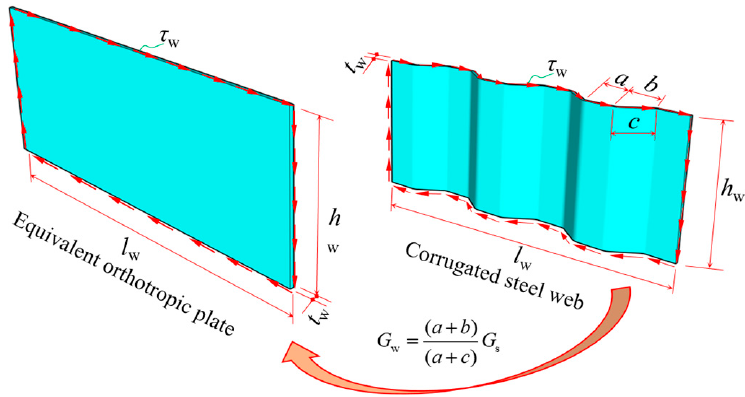
Figure 4. Equivalent of corrugated steel webs.